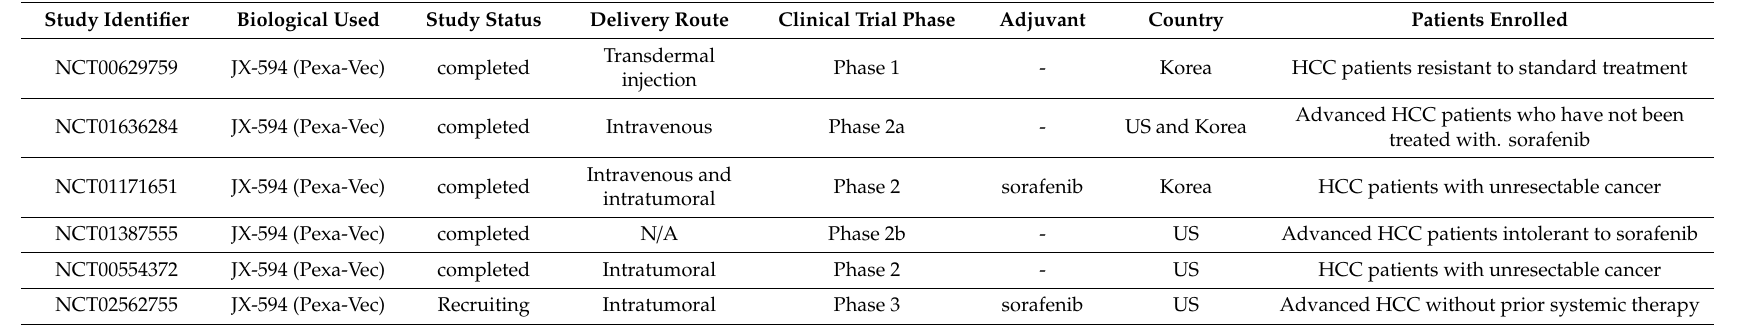
Table 4. Data from clinicaltrials.gov as of 07.13.2019 showing clinical trials that use JX-594. (Pexa-Vec) to treat